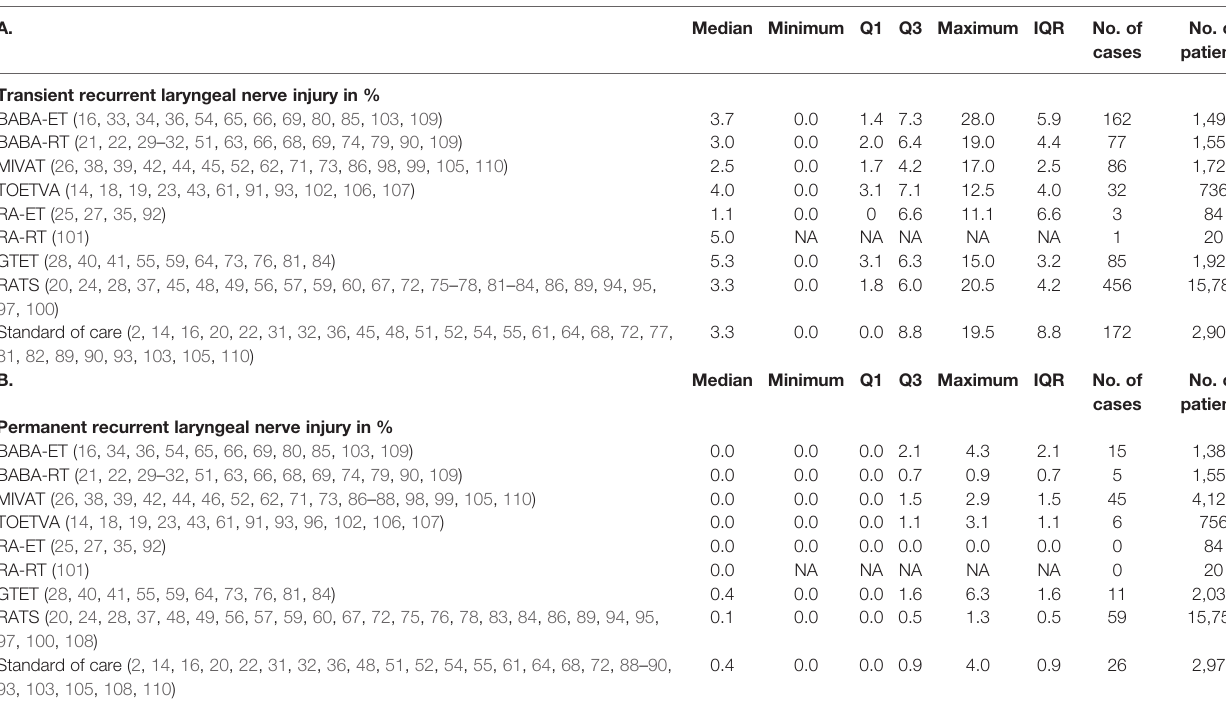
TABLE 2 | Incidence of recurrent laryngeal nerve